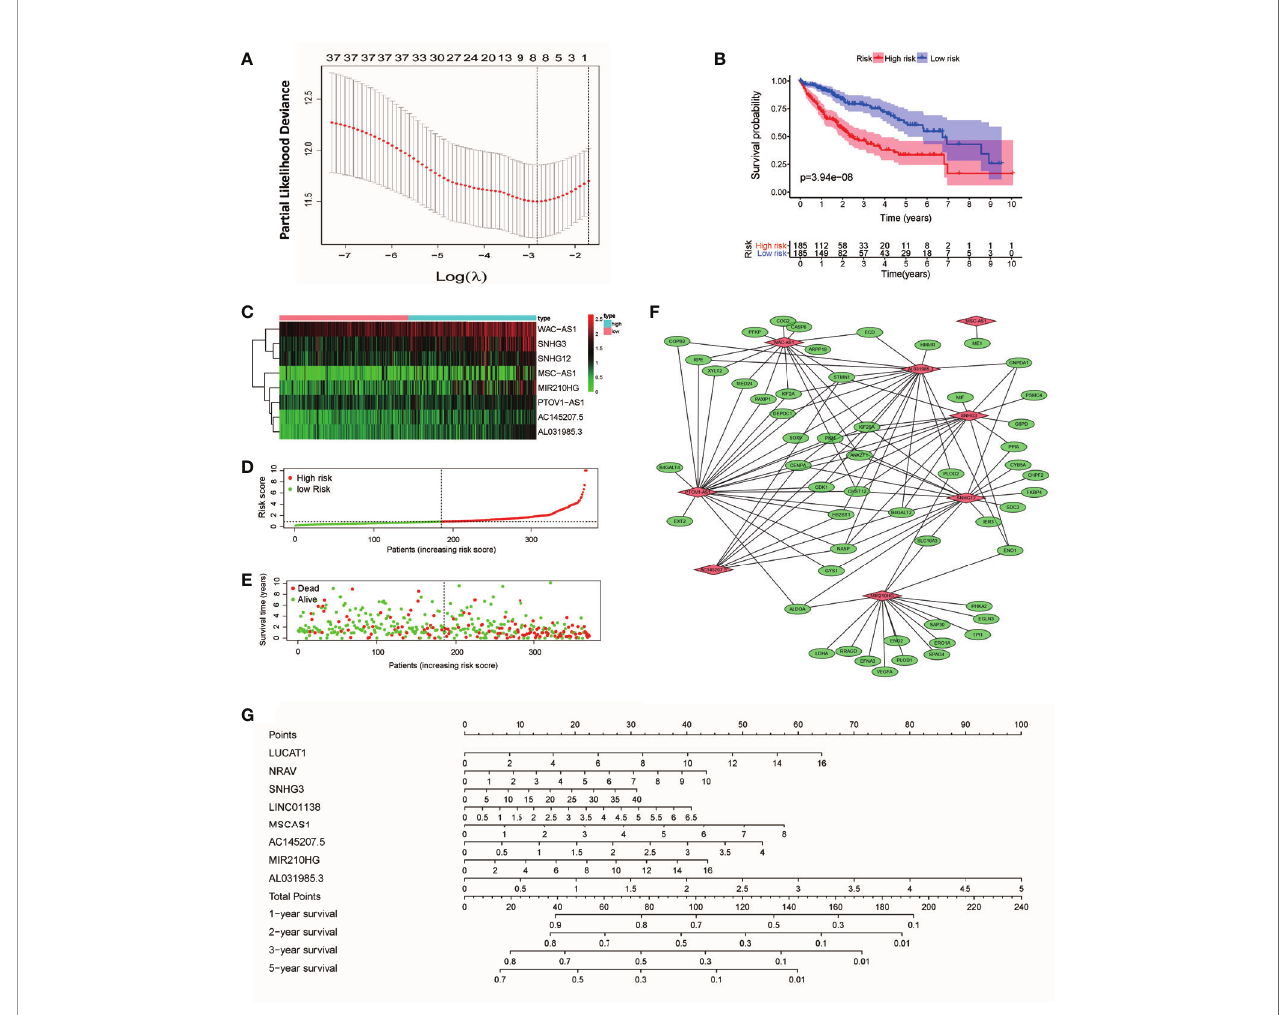
FIGURE 2 | Construction of the prognostic model and nomogram. (A) “ Leave-one-out ” cross-validation for parameter selection during LASSO regression; (B) survival curves of patients in the high-risk and low-risk groups; (C) heatmap of lncRNAs in the model; (D) curve of the risk score; (E) distribution of survival status; (F) co-expression relationship between glycolytic genes and lncRNAs in the model; (G) nomogram for survival